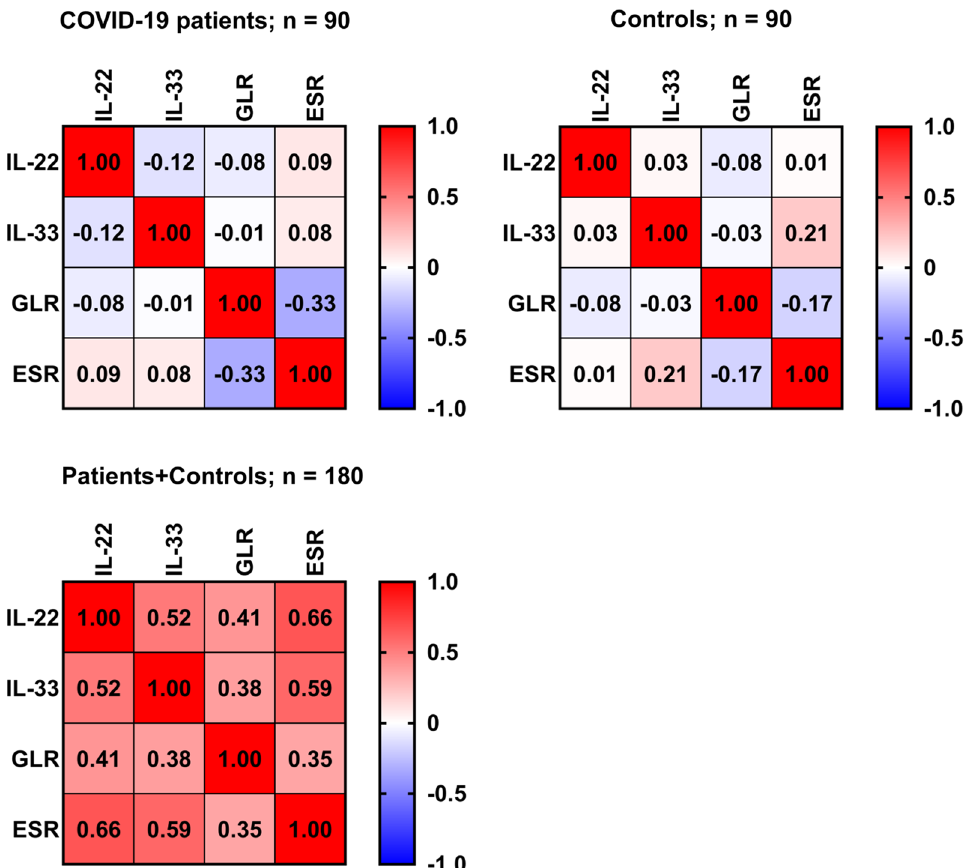
Fig. 4 Heat-map matrix of correlation (Spearman’s rank correlation analysis) between IL-22, IL-33, granulocyte-to-lymphocyte ratio (GLR), and erythrocyte sedimentation rate (ESR) among COVID- 19 patients only, healthy controls (HC) only, and patients plus HC. Values inside boxes indicate the correlation coefficient (r s ). Red color indicates a positive correlation, while blue color indicates a negative correlation. IL-22 and IL-33 showed no significant correlation in COVID-19 patients (r s 0.12; p 0.258) or HC (r s 0.03; p 0.775). In addition, both cytokines showed no significant = − = = = correlation with GLR and ESR in patients or HC. IL-33 and ESR were an exception and showed significant positive correlation in HC (r s 0.21; = p 0.049). GLR negatively correlated with ESR in patients (r s 0.33) and HC (r s 0.17), but the correlation was only significant in patients = = − = − ( p 0.001). However, the pattern of correlations was different when the analysis was performed in all participants (COVID-19 patients plus HC). = IL-22 positively correlated with IL-33 (r s 0.52; p < 0.001), GLR (r s 0.41; p < 0.001), and ESR (r s 0.66; p < 0.001). IL-33 positively correlated with GLR = = = (r s 0.38; p < 0.001) and ESR (r s 0.59; p < 0.001). Finally, a positive correlation between GLR and ESR was found (r s 0.35; p < = = =